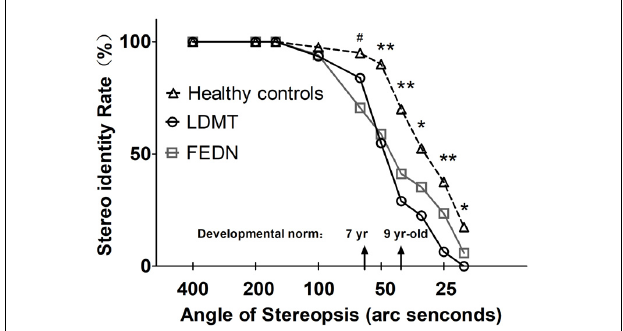
(mean ± SEM = 1.71 ± 0.07, median = 1.70, 95% CI: [1.30, 2.20]) and LDMT groups (mean ± SEM = 1.73 ± 0.04, median = 1.70, 95% CI: [1.40, 2.20]).